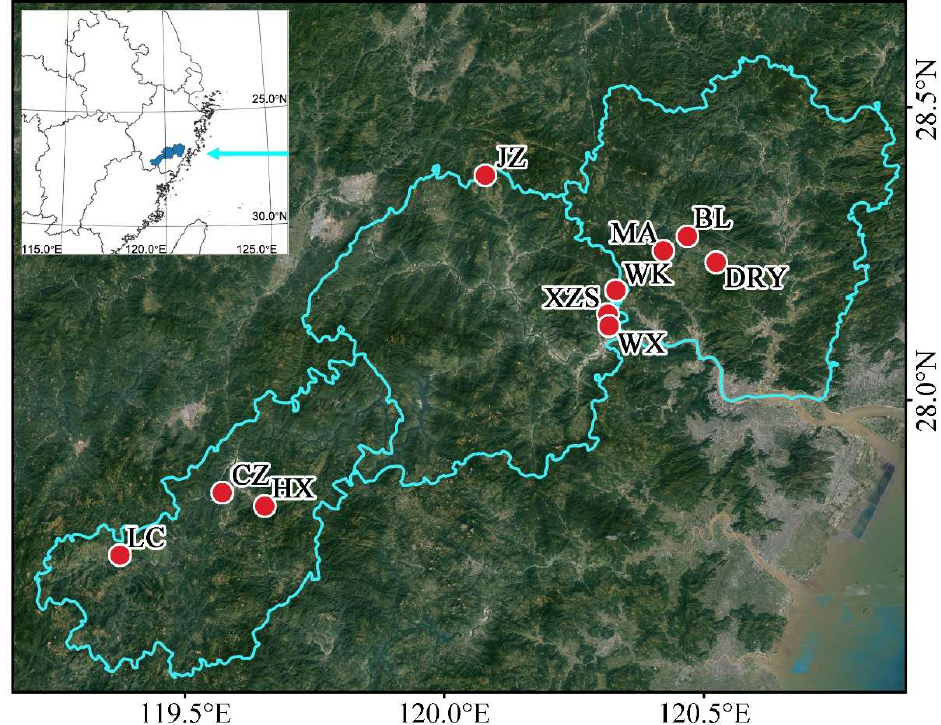
Figure 1. The sampling locations of common carp ( C. carpio ) in the traditional rice–fish coculture system in the south of Zhejiang Province, China. Table 1. Collection details for C. carpio cocultured in paddies in the south of Zhejiang Province, China.